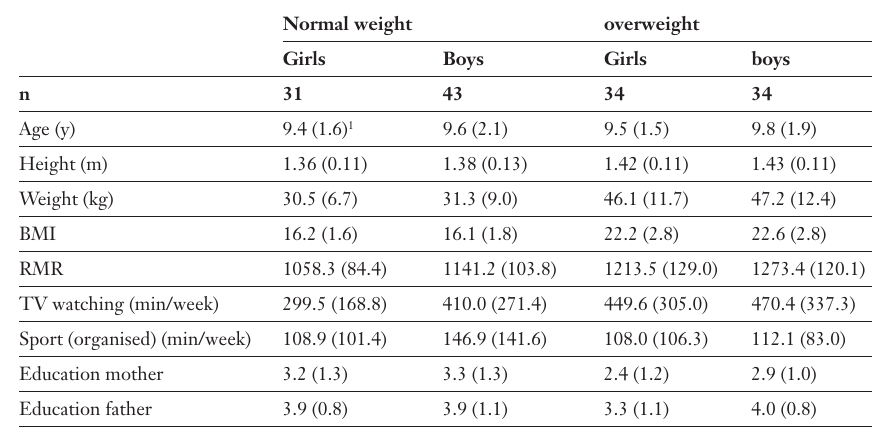
Table 1 Anthropometric data of all children divided by gender and weight